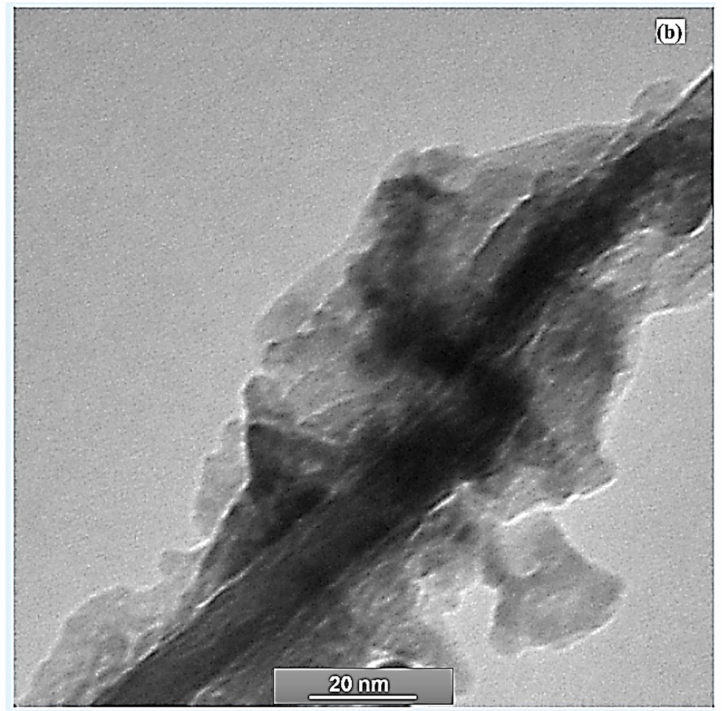
Figure 5. HR-TEM images for silica nanofibers on the surface of SiO 2 with dispersion (Silad3.5): ( a ) 50 nm scale ( b ) 20 nm